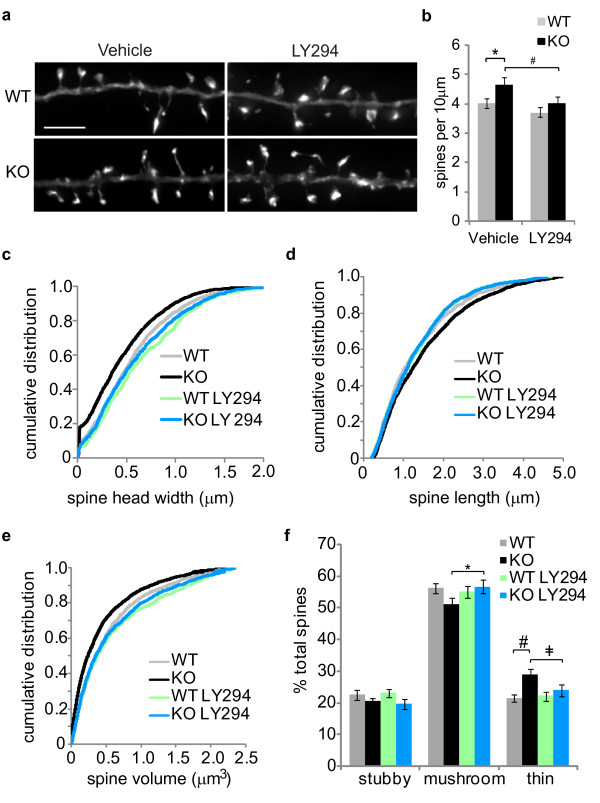
A PI3 kinase inhibitor rescues spine morphology in neurons from Fmr1 knockout mice. (a) Hippocampal neurons cultured from wild type (WT) or Fmr1 knockout (KO) mice were treated with vehicle or a PI3 kinase inhibitor (LY294, 10 μM) for 72 hours starting at 15 DIV. Neurons were transfected with a plasmid encoding Lifeact-ruby at 17 DIV and fixed 24 hours later. The images depict representative dendritic regions from deconvolved z-series images (scale bar is 5 μm). (b) Spine density was measured using our automated approach for WT and KO neurons treated with either vehicle or LY294 (n = 55-60 neurons; ANOVA [F = 3.996, P = 0.009]; post-hoc Fisher's LSD: *P = 0.017, #P = 0.028). Cumulative distributions of (c) spine head width, (d) length, and (e) volume were plotted for each group (Kolmogorov-Smirnov test: head width [WT vs. KO: P = 0.002, WT vs. WT LY294: P = 0.235, KO vs. KO LY294: P = 0.009], spine length [WT vs. KO: P = 0.009, WT vs. WT LY294: P = 0.537, KO vs. KO LY294: P = 0.014], spine volume [WT vs. KO: P < 0.001, WT vs. WT LY294: P = 0.158, KO vs. KO LY294: P < 0.001]). (f) Spines were classified as stubby, mushroom, and thin based on the automated geometric measurement, and the values were plotted as percentage of total spines per treatment group (n = 55 - 60 neurons; ANOVA with post-hoc Fisher's LSD: *P = 0.043, #P = 0.006, ‡P = 0.043).